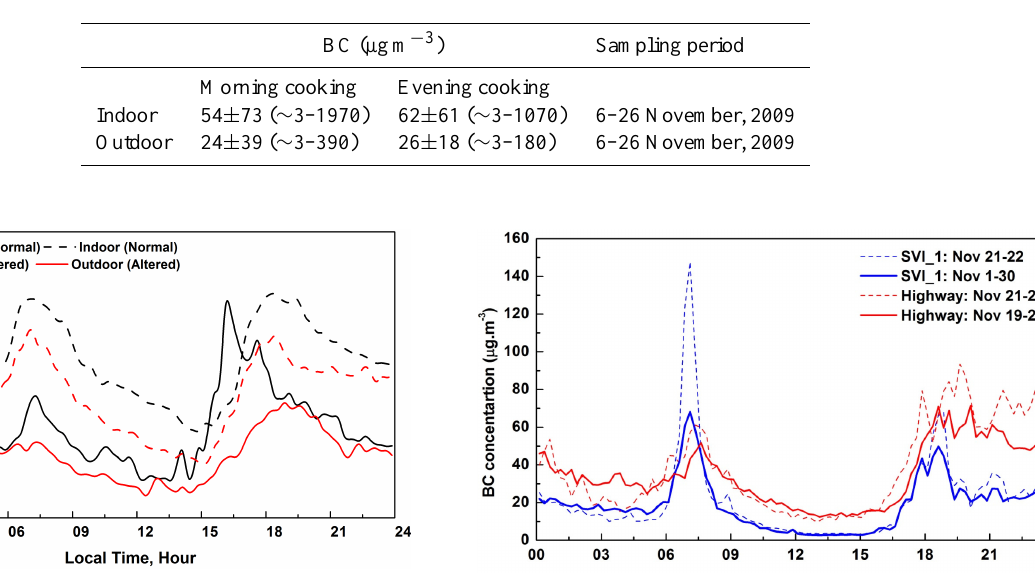
Table 1. Mean BC concentration for indoor (kitchen) and outdoor (ambient) in Surya village (SVI 1). The values in bracket represent the range of BC concentration.